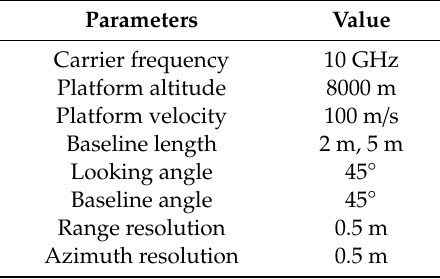
Table 1. Parameters of double-baseline